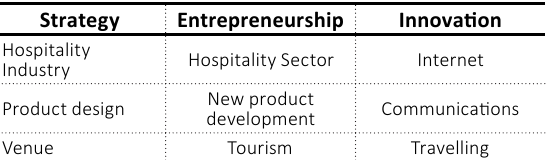
Table 2. Search terms